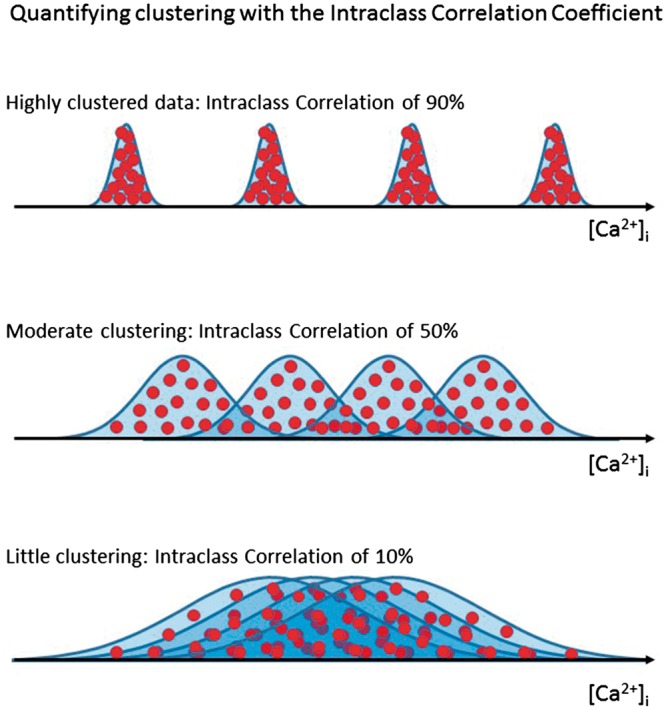
Intraclass correlation in cardiomyocyte studies. Examples of data with high, moderate, or low intraclass correlations (ICCs). Intracellular calcium concentration ([Ca2+]i) from individual cells (red dots) is clustered into histograms making up the data distributions in individual rat hearts. In the top panel, there is a high ICC with data clustered tightly in each heart. In the middle panel, there is an intermediate ICC and in the bottom panel there is a low ICC with a high proportion of the overall variability coming from each individual heart. A larger correction to common statistical techniques is required in data with a high ICC.